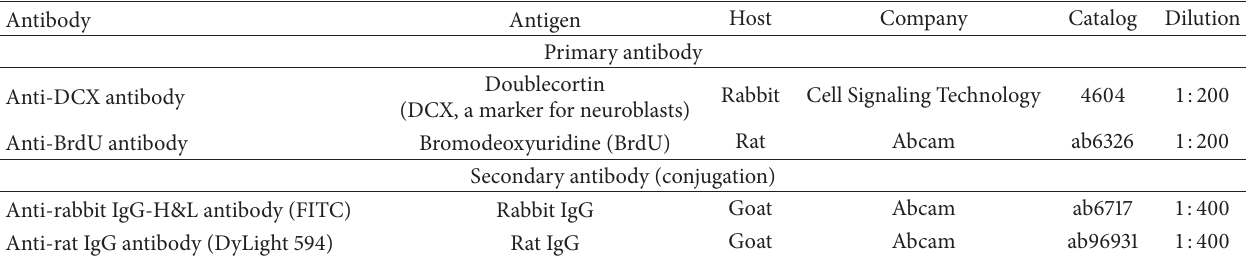
Table 1: Antibodies used for immunofluorescence